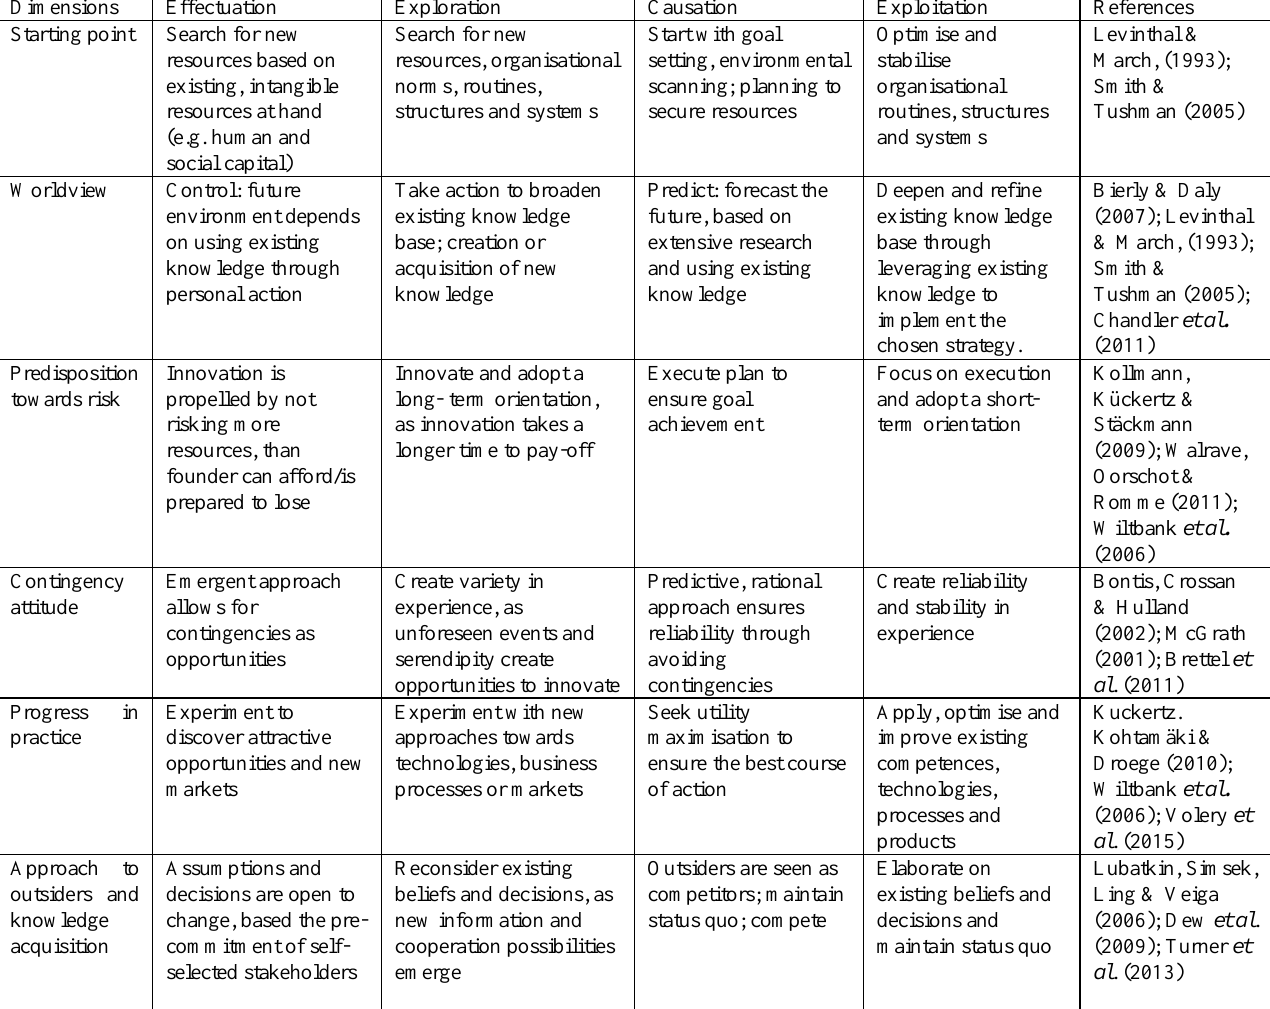
Table 1: Relating effectuation to exploration and causation to exploitation as ambidextrous strategies